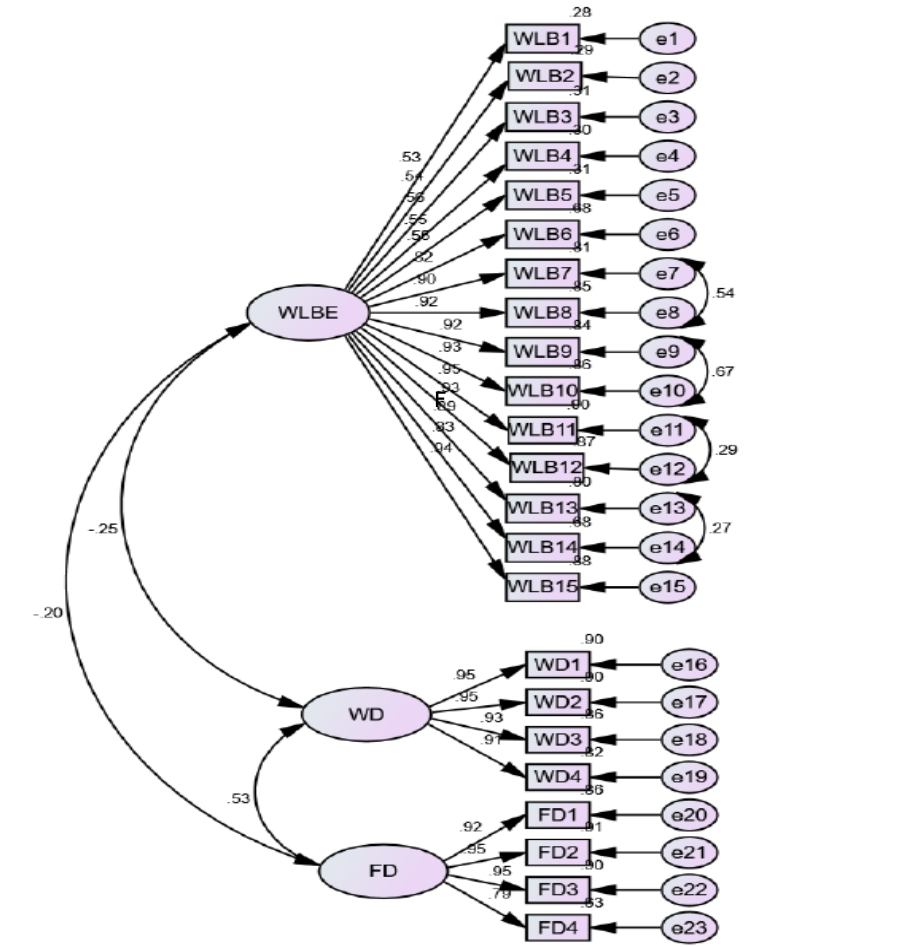
Figure 2: The Modified full Measurement Model Source: Results of AMOS graphics,